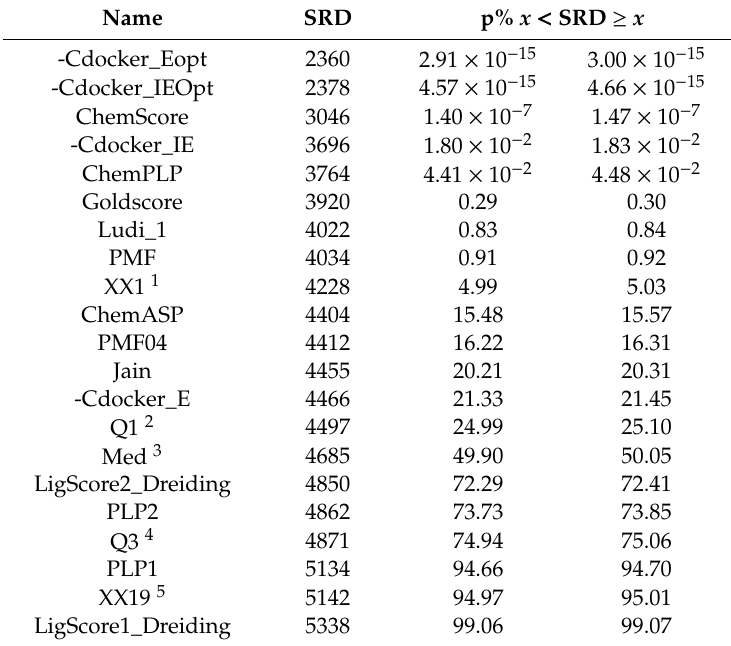
Table 11. SRD ranking of the 16 fitness functions used in the CDOCKER run.